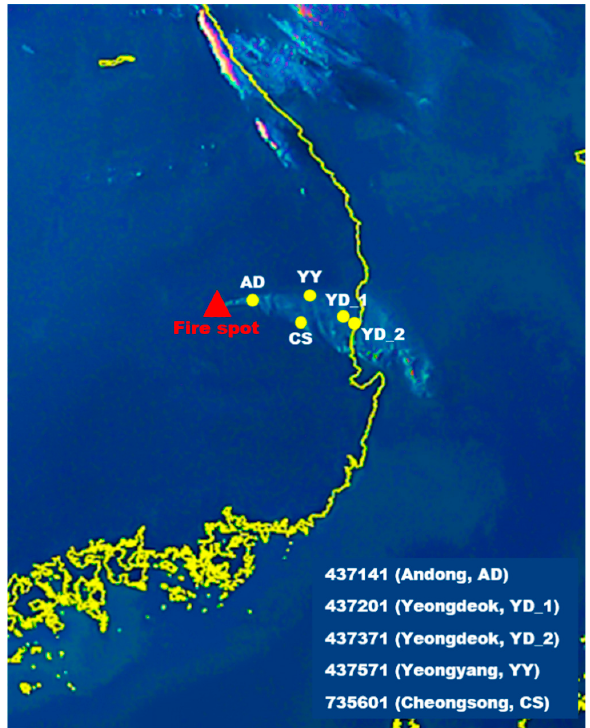
Figure 3. Andong wildfire plume observed by the Himawari-8 satellite. The yellow circles are the AQMS sites located in the moving direction of the plume.